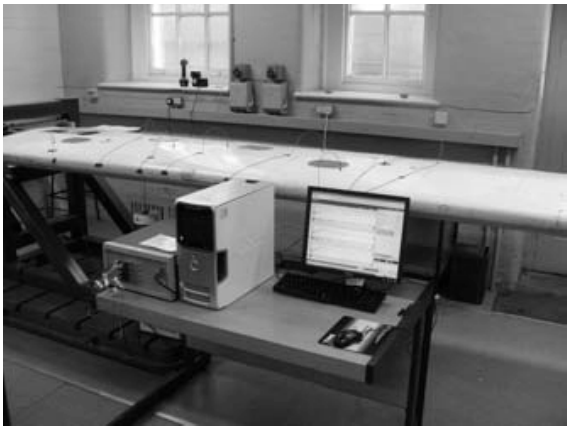
Fig. 3. Data acquisition set-up.